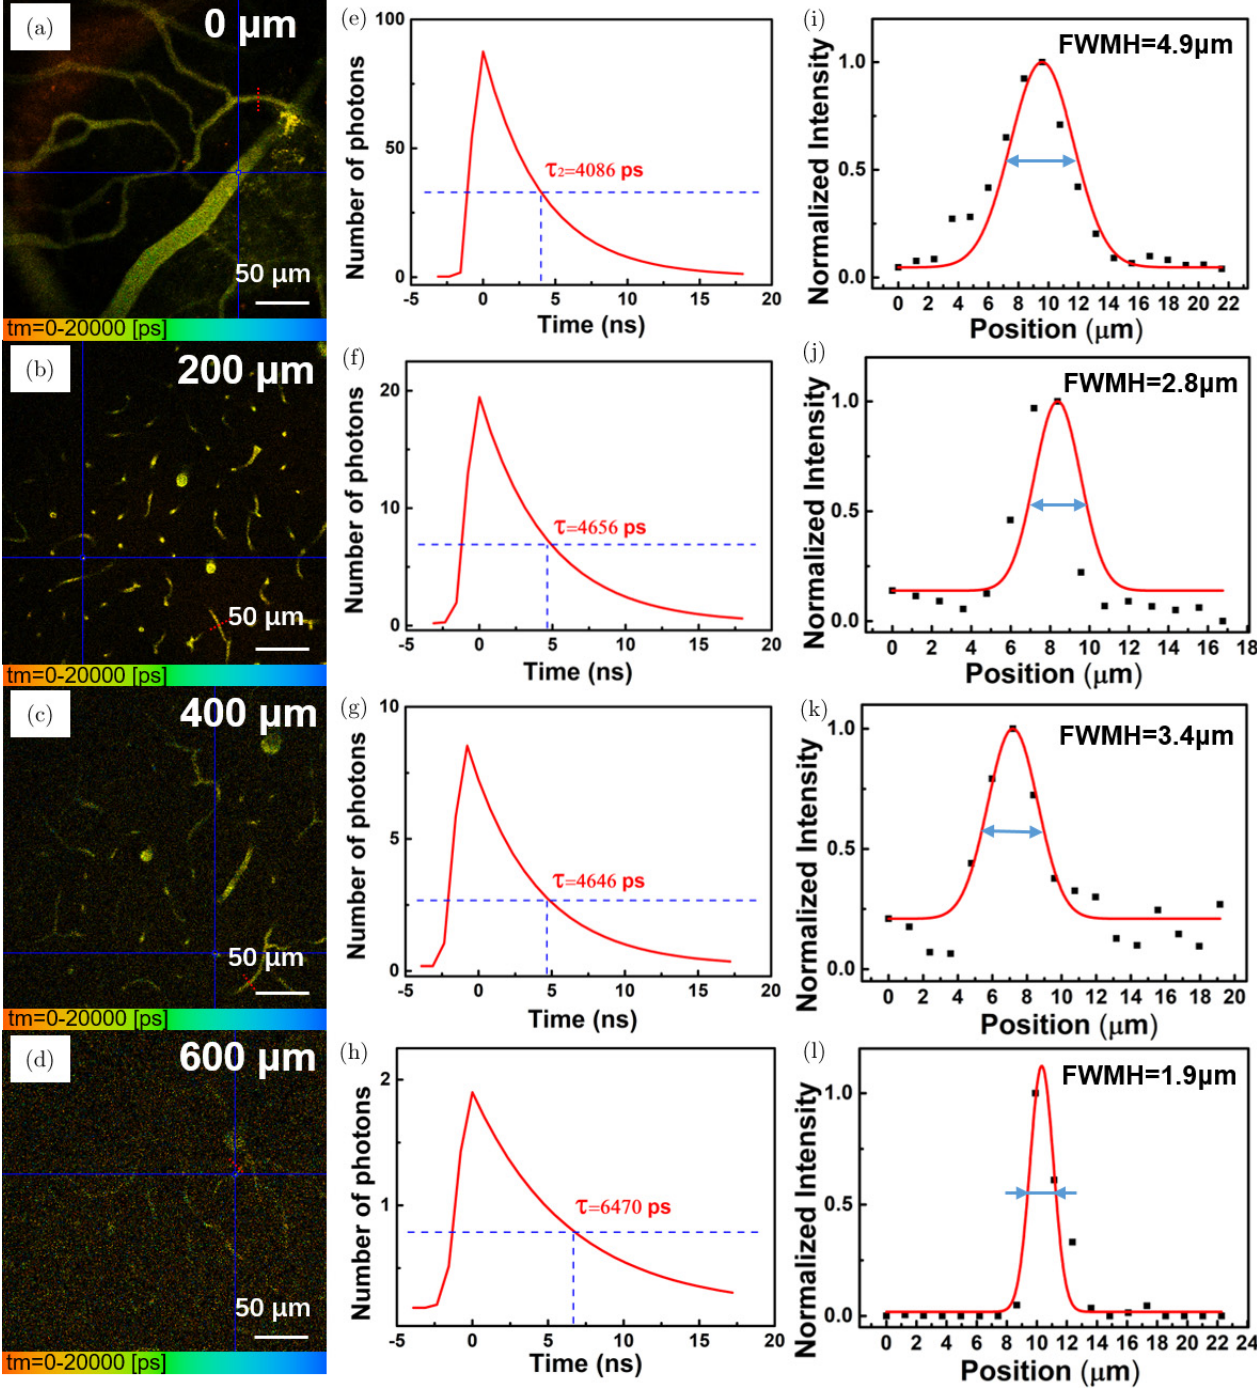
Fig. 4. ((a), (d), (g), (j)) In vivo 3PFLIM images of brain vasculature of mouse with craniotomy at various vertical depths: 0, 200, 400 and 600 (cid:1) m. (Scale bar: 50 (cid:1) m) ((b), (e), (h), (k)) Time-resolved decay pro¯les of the intersection of blue lines (drawn in ((a), (d), (g), (j))) at various vertical depths. ((c), (f), (i), (l)) The cross-sectional intensity pro¯les across the capillary vessels marked with red-dashed lines in ((a), (d), (g),